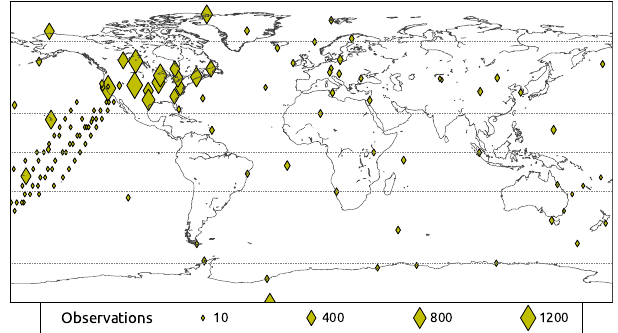
Fig. 1. Locations of the point samples assimilated in our inversions. The marker size represents the amount of observational data from each location assimilated in our inversions. For example, although there is a high density of location markers over the tropical Pacific, there are very few data points from each of those locations, since the data there come from one-time